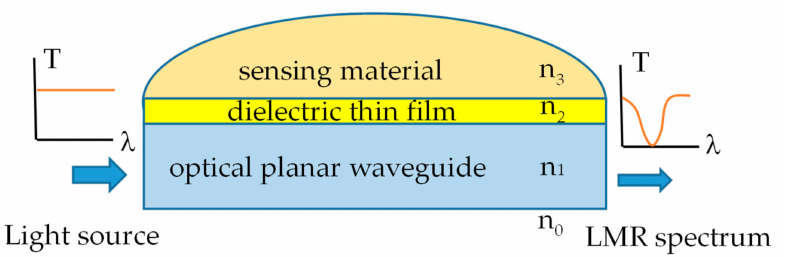
Figure 1. Three-layer structure for lossy mode resonance-based optical planar waveguide (LMROPW)